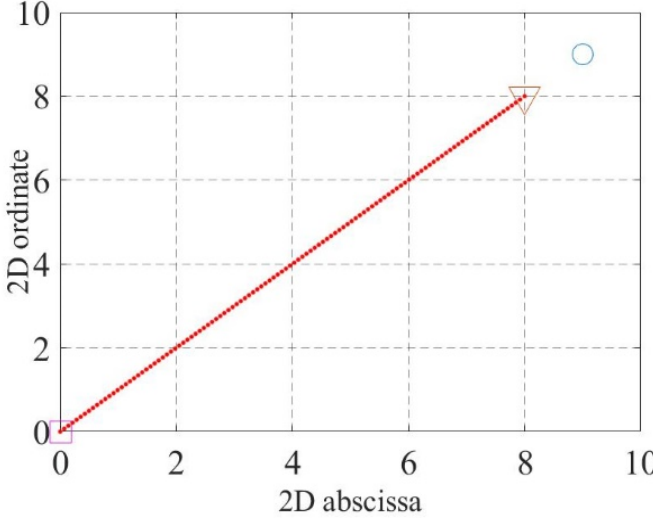
Figure 12. Simulation results when the target point is in the middle.